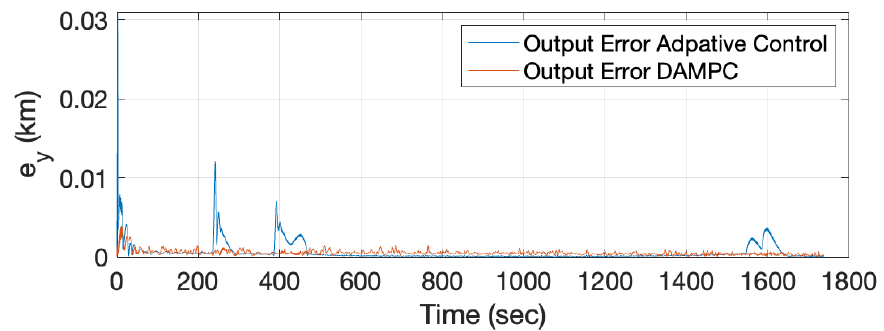
Figure 14. Output error magnitude for adaptive control and